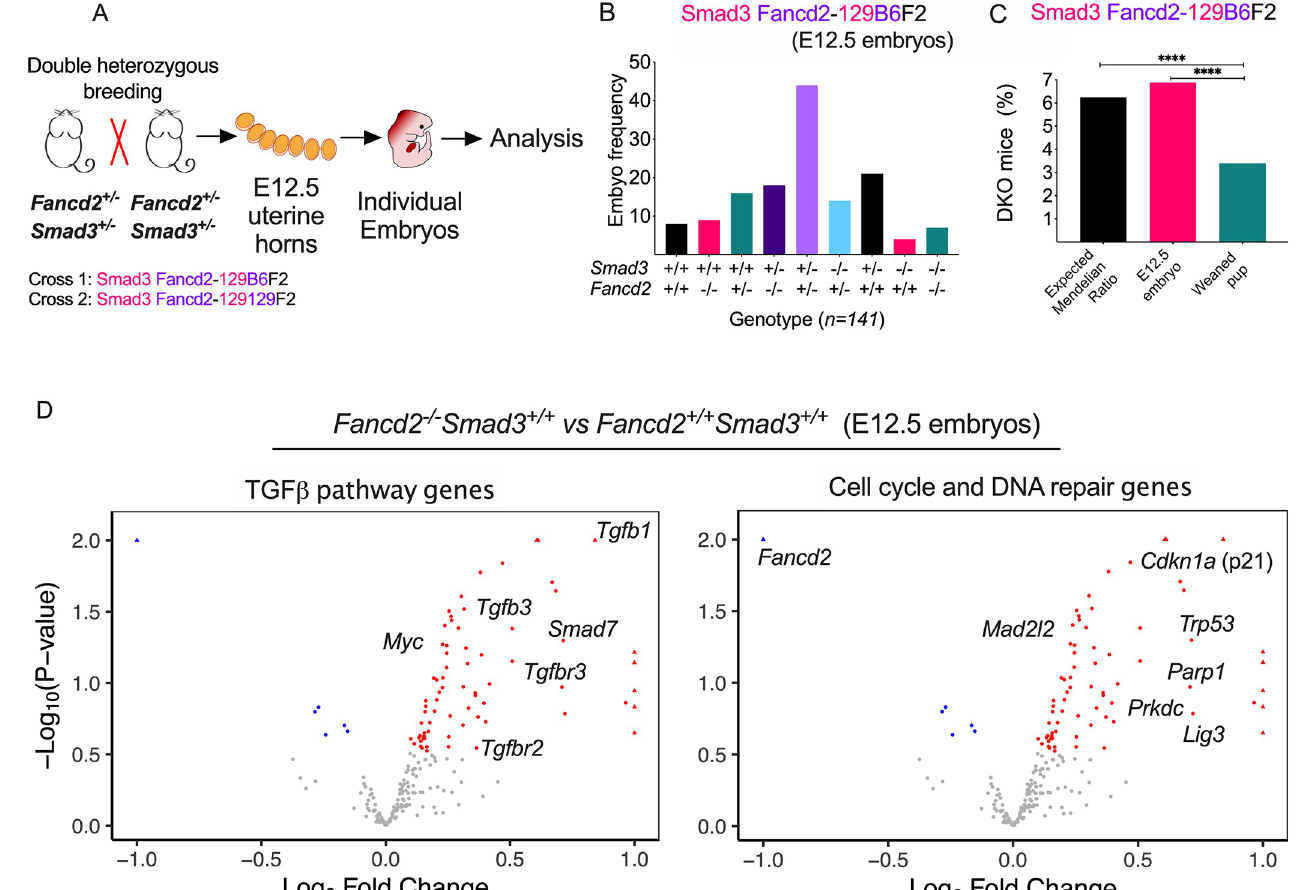
Fig 3. Fancd2 -/- embryos overexpress the TGF β pathway and error-prone DNA repair genes. (A) Fancd2/Smad3 heterozygous littermates were crossed to breed. Pregnant females were sacrificed at day E12.5 of gestation, uterine horns were dissected, and embryos genotyped. RNA from embryos was analyzed for expression of genes in the TGF β pathway and DNA repair pathways. (B) Smad3 Fancd2-129B6F2 breeding has a Mendelian distribution at day E12.5, showing that Smad3 Fancd2-129B6F2 embryos can survive until day E12.5 of embryonic development ( n = 141 embryos ). (C) The frequency of Smad3 Fancd2-129B6F2 embryos at day E12.5 yields the expected Mendelian ratio, however the frequency of weaned Smad3 Fancd2-129B6F2 pups is halved, suggesting later lethality during embryonic development. (D) Gene expression analysis of E12.5 embryos. Left . Compared to WT embryos, Fancd2 -/- embryos overexpress TGF β pathway-related genes and overexpress the ligands for activation of the TGF β pathway, Tgfb1 and Tgfb3 , as well as their receptors Tgfbr2 and Tgfbr3 . The oncogene Myc was also found to be overexpressed in Fancd2 -/- embryos. Right . Compared to WT embryos, Fancd2 -/- embryos overexpress genes related to alternative DNA repair pathways, including Prkdc , Mad2l2 and Parp1 , as well as negative regulators of cell cycle progression, including Trp53 (p53) and Cdkn1a (p21). Red dots indicate differentially upregulated genes with respect to wild type embryos. Blue dots indicate differentially downregulated genes with respect to wild type embryos. Data in (B) and (C) are represented as bar plots. Data in (D) are represented as volcano plots. p values of 0.01 to 0.05 were considered significant ( � ), p values of 0.001 to 0.01 were considered very significant ( �� ) and p values of < 0.001 were considered extremely significant ( ��� , ���� ). See also S3